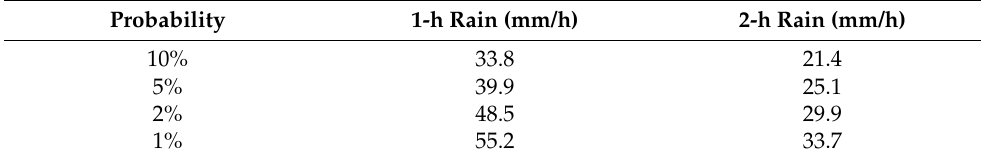
Table 2. Rain intensities (mm/h) for 1 h and 2 h from the Beit Dagan meteorological station.